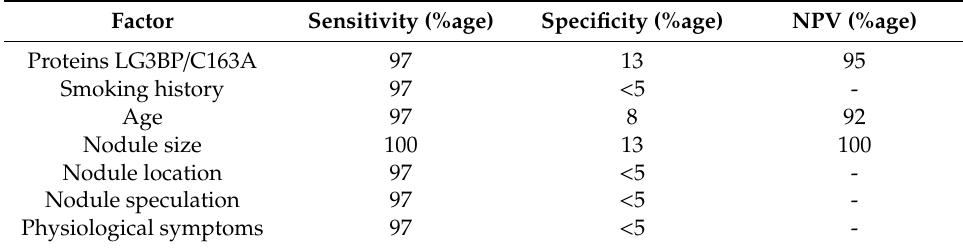
Table 1. Relative contribution of risk factors with clinical biomarkers [3].